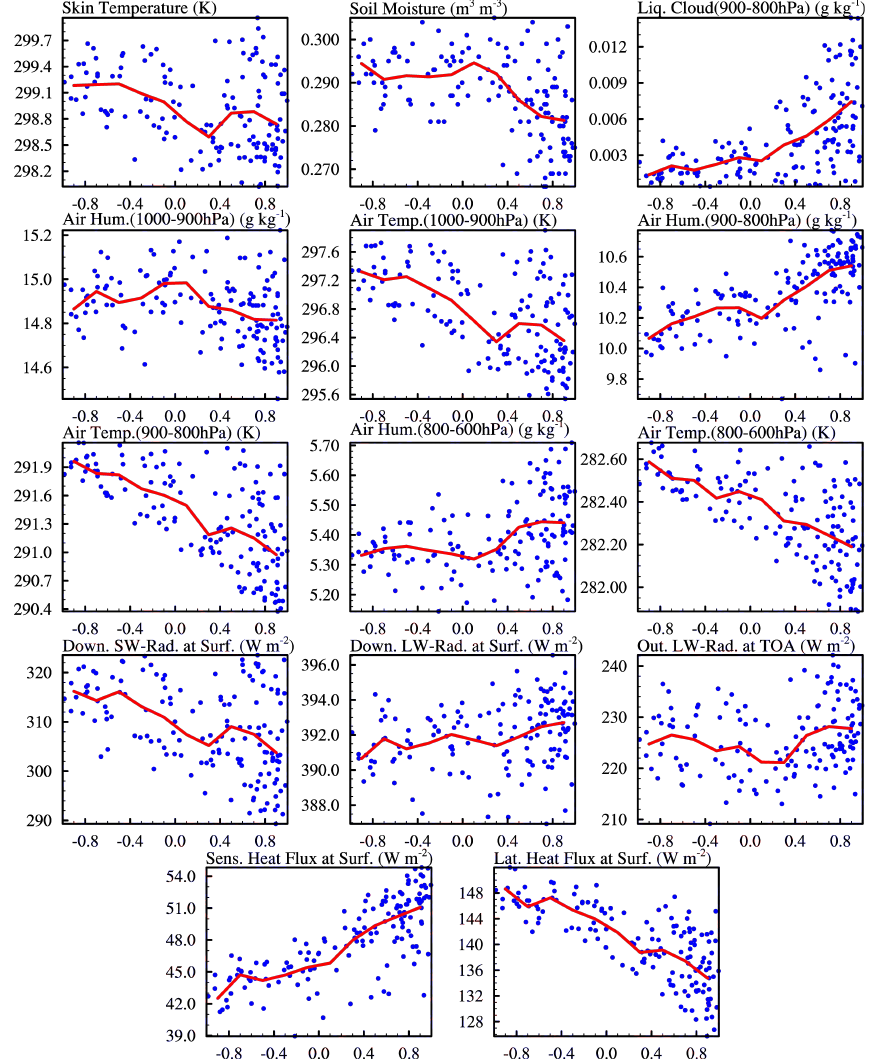
Fig. 8. The response of 14 model output variables (see Table 3) to the downdraft mass flux related parameter P d based on the 148 simulations (25km) over